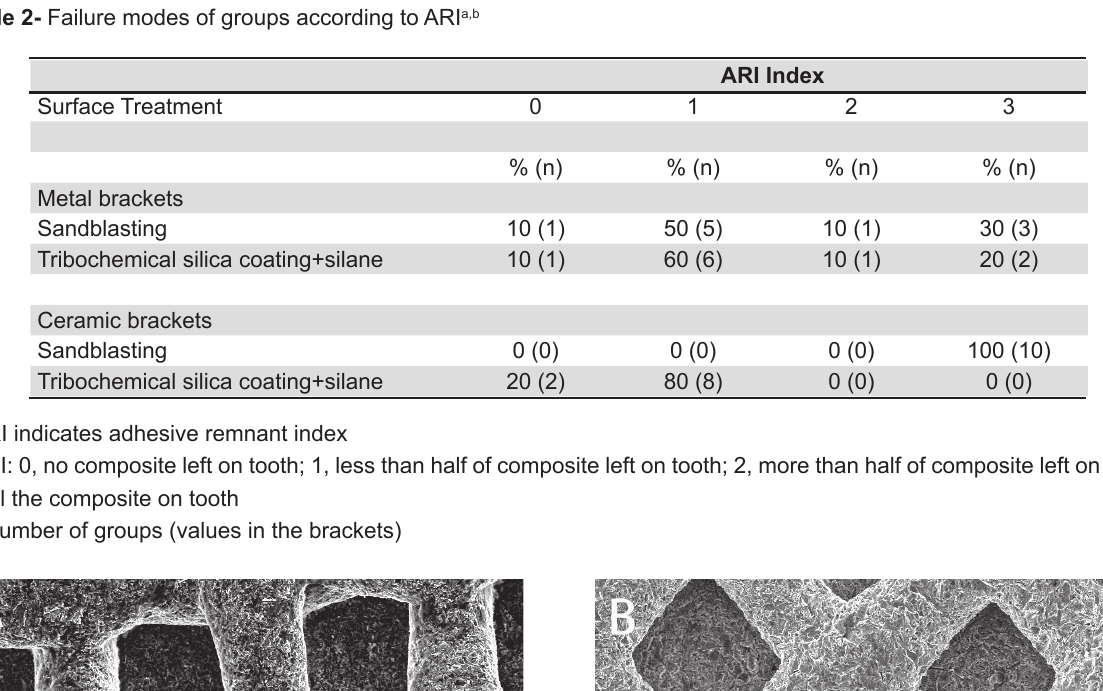
Table 2- Failure modes of groups according to ARI a,b